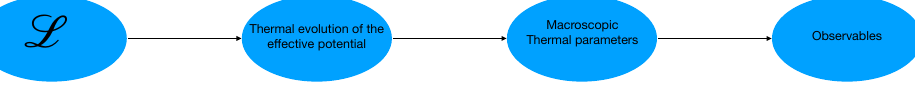
Figure 1 . The uncertainty in linking a particular model with a set of observables is conceptually presented above. The break down of perturbation theory at finite temperature is the dominant error in the prediction of the evolution of the effective potential and ultimately non-perturbative methods might be required to predict macroscopic thermal parameters. The macroscopic thermal parameters of interest are often taken to be the latent heat, the time scale of the transition (usually approximated), the bubble wall velocity and the temperature of percolation, but if one desires to have an accurate prediction one needs the fluid velocity, the wall velocity, the mean bubble separation, the percolation temperature and the lifetime of the acoustic source (see also figure 1 of